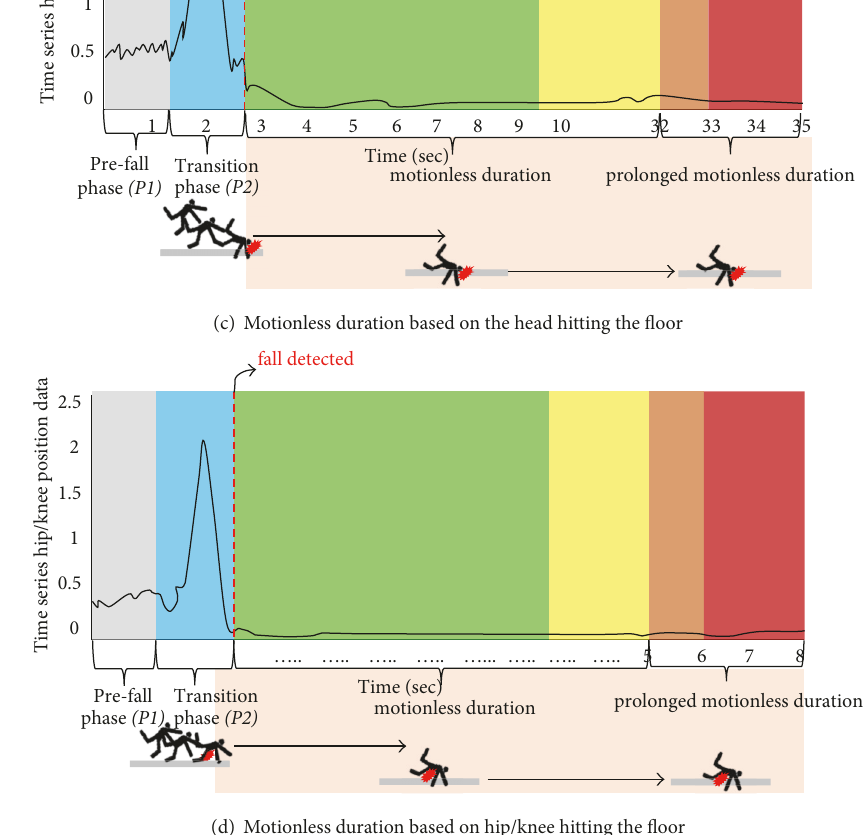
Figure 4: Motionless duration detection after a